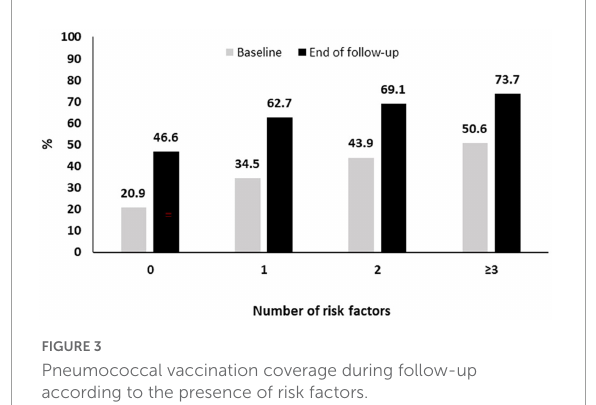
FIGURE3 Pneumococcal vaccination coverage during follow-up according to the presence of risk